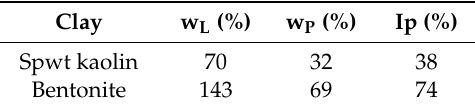
Table 2. Atterberg limits.